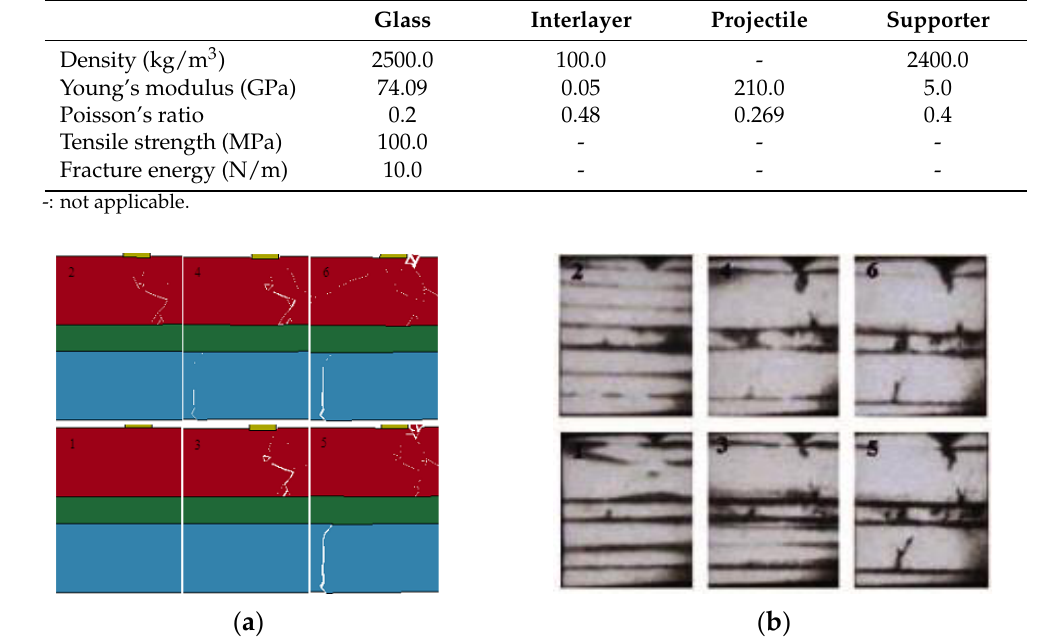
Figure 9. Impact fracture results: ( a ) FDEM; ( b ) Experiment (Adapted from Ref. [44]). The FDEM simulation agrees very well with the experimental snapshots. Cracks are observed in the upper glass, and a dominant bending crack has formed at a similar location and time as in the experimental records. Figure 10 shows the change of the vertical projectile velocity against time from the FDEM simulation. It can be seen that the velocity is in monotonic descending, and the residual velocity at t = 500 µ s ( v = 2.82 m/s) is about 90% of the initial impact velocity, suggesting that the projectile can further damage the laminated glass should the FDEM simulation proceed.